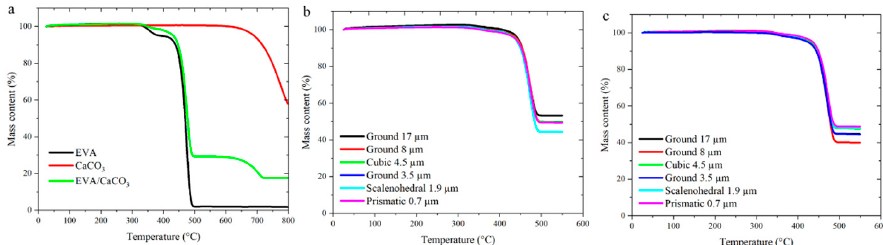
Figure 6. TGA analysis of CaCO 3 powder and neat EVA resin as a degradation benchmark ( a ), injection-molded composites ( b ), and extruded composites ( c ).